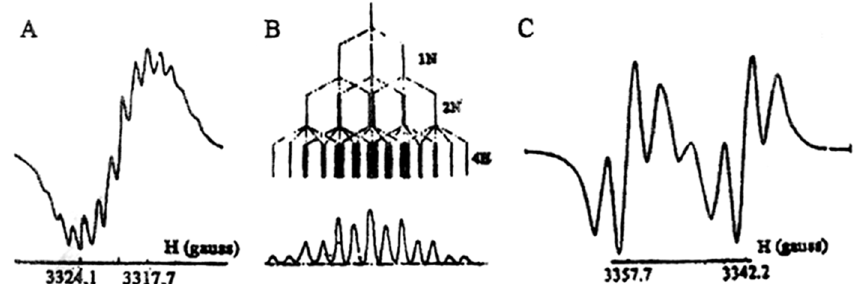
Figure 3. ( A ) The EPR signal of DNIC with cysteine recorded at ambient temperature [53]. ( B ) The deciphering of the 13-component HFS of signal A: the triplet and the quintet HFS, respectively, from one and two nuclei of N 14 (nuclear spin I = 1) of two nitrosyl ligands + additional HFS from four protons (I = 1/2) of the methylene group in two cysteine ligands of DNIC with cysteine [22]. ( C ) The doublet HFS of the Fe 57 nucleus (I = 1/2) in DNIC with hydroxyl ligands. The triplet HFS was iden- tified by the hyperfine interaction of the unpaired electron with two nuclei of N 15 (I = 1/2) incorpo- rated into nitrosyl ligands of DNIC [53].